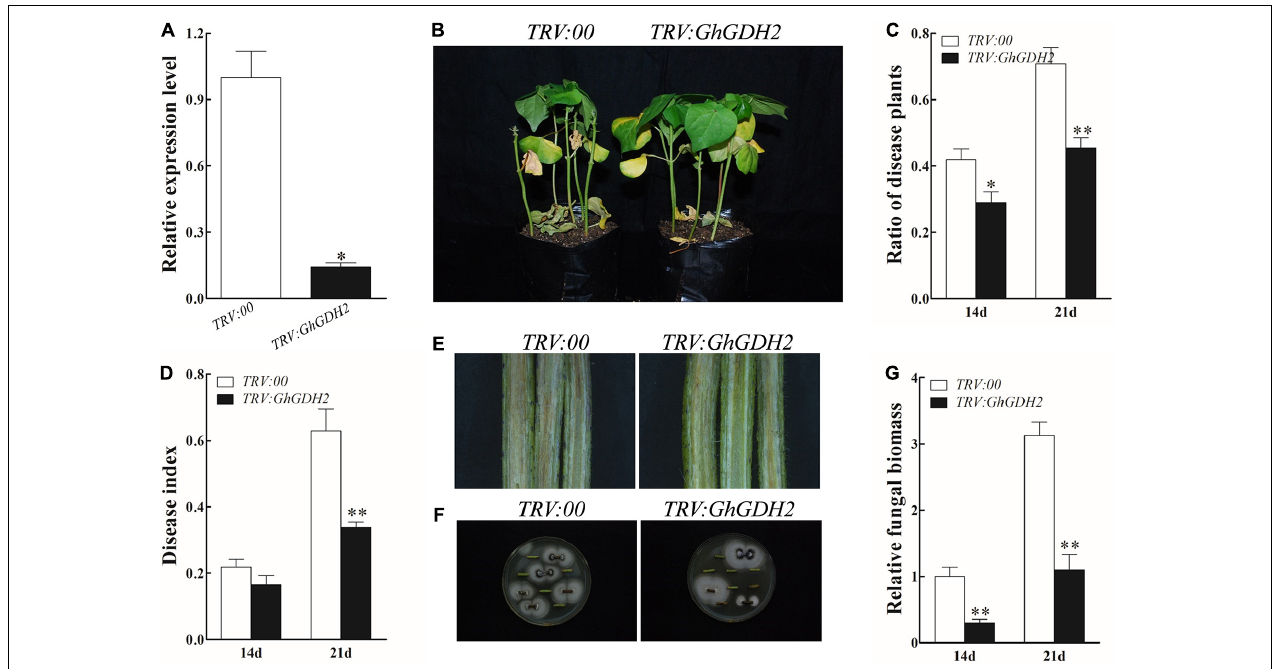
FIGURE 7 | Knockdown of GhGDH2 in Verticillium dahliae -susceptible cultivar Junmian 1 enhanced disease resistance. (A) GhGDH2 expression in the TRV:00 and TRV:GhGDH2 plants. RNA was extracted from roots at 2 weeks after infiltration with the VIGS vector. (B) Disease phenotypes of the TRV:00 and TRV:GhGDH2 plants at 21 dpi. (C,D) Ratio of diseased plants and disease index of TRV:00 and TRV:GhGDH2 plants at 14 and 21 dpi. (E,F) Fungal recovery assay (E) and longitudinal sections of cotton stems (F) from TRV:00 and TRV:GhGDH2 plants at 14 dpi. (G) Comparison of fungal biomass. The roots from the TRV:00 and TRV: GhGDH2 plants at 14 and 21 dpi was used to extracted total DNA, which was used as a template for relative fungal biomass analysis by quantitative PCR analysis. Values represent mean ± SE of three independent biological replications (five individual plants per replicate). ∗ and ∗∗ represent significant differences from TRV:00 at P < 0.05 and P < 0.01, respectively, based on Student’s t